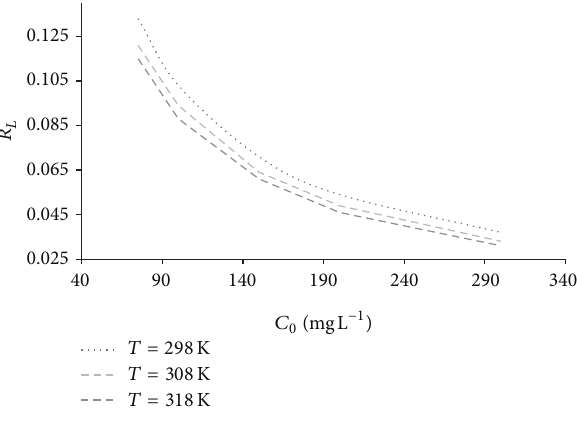
Figure8:Comparisonof 𝑅 𝐿 absorptionofMBontoCHAC Z inthree